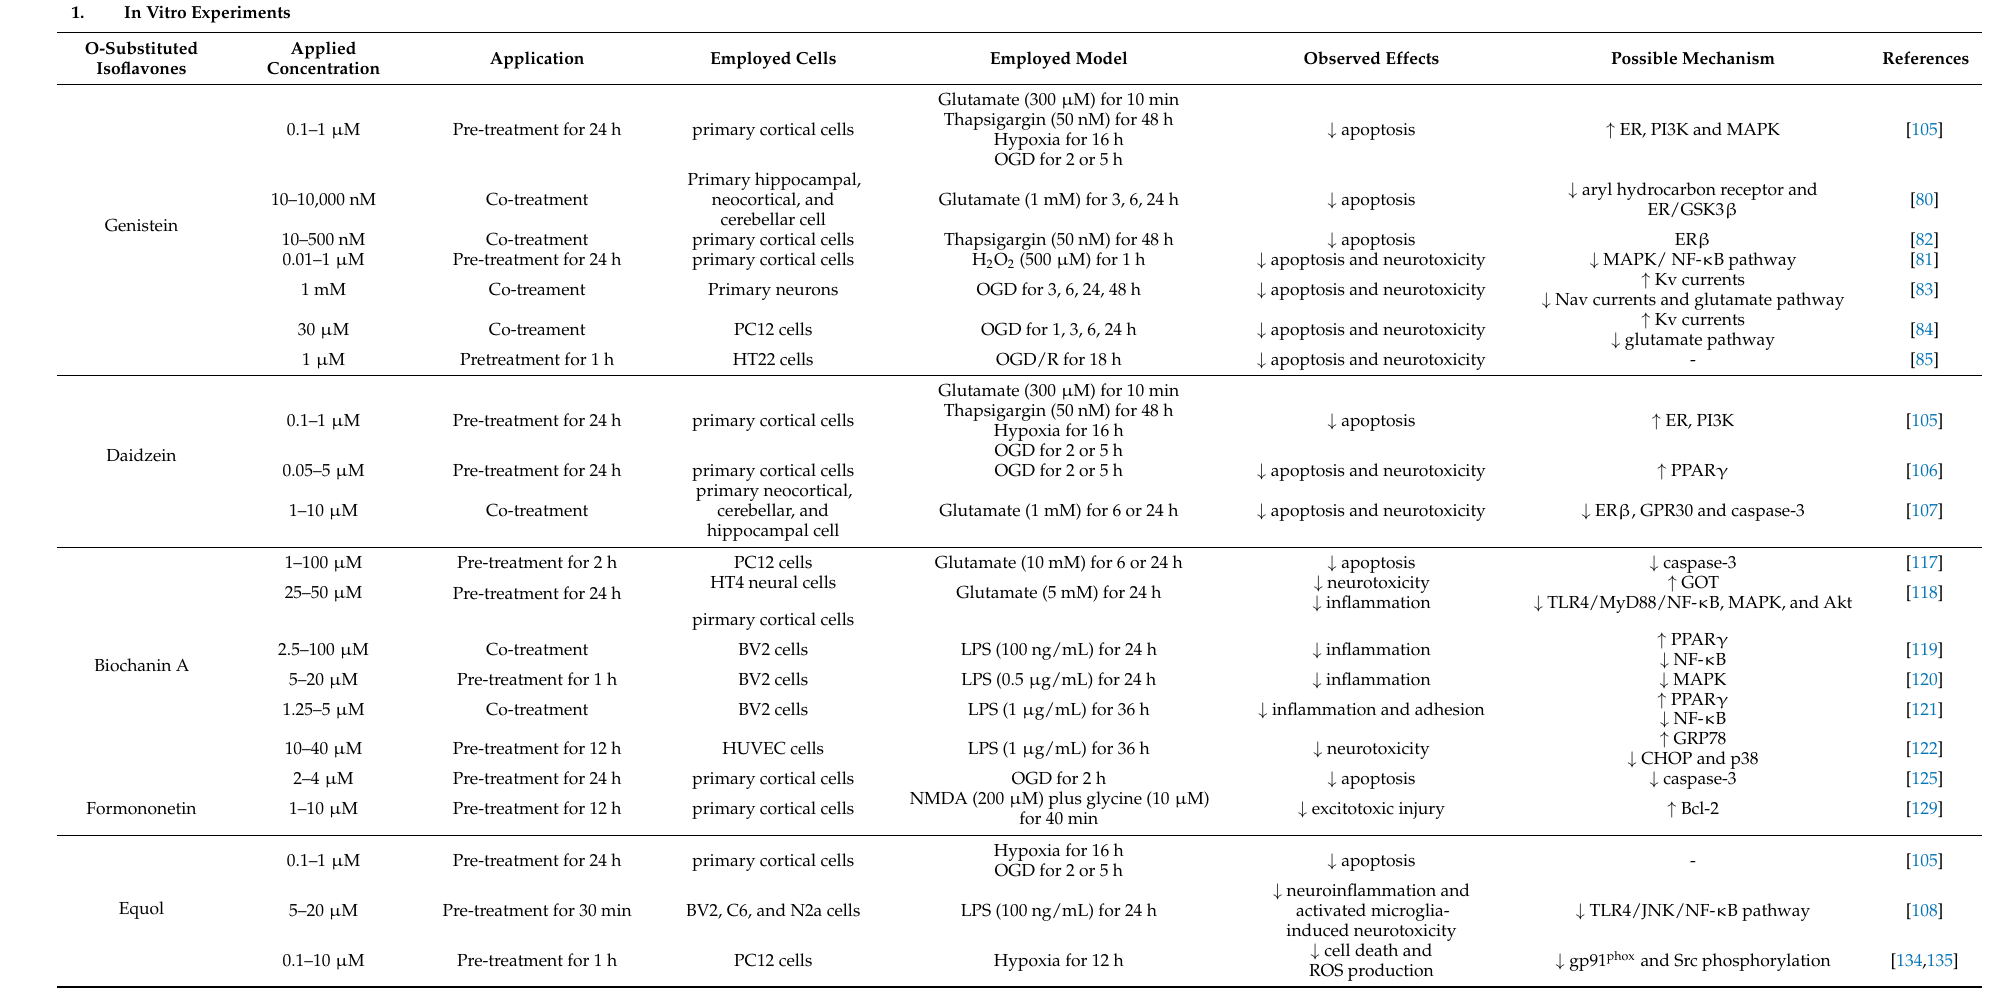
Table 1. The protective effects of O-substituted isoflavones against ischemia reperfusion (IR)